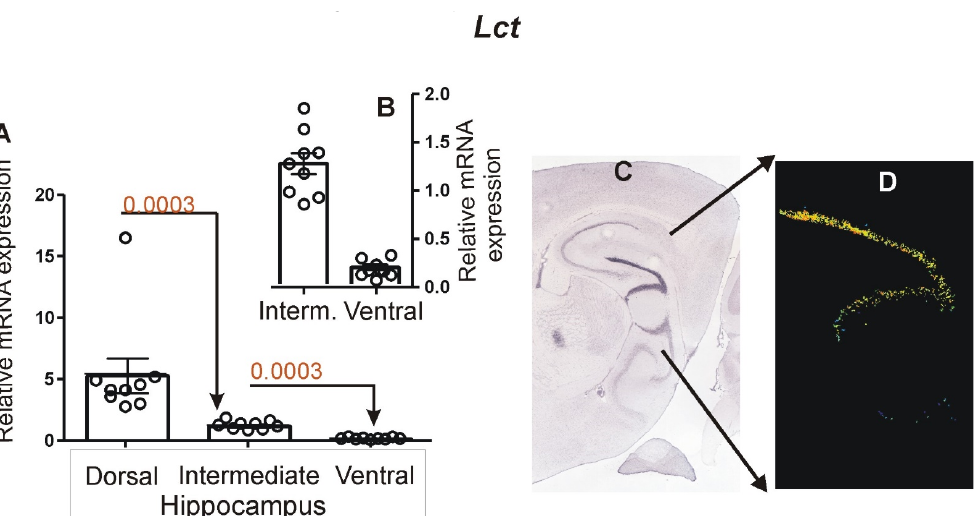
Figure 6. Hippocampal expression of Lct . ( A ) Results of PCR analysis performed on dissected samples of dorsal, intermediate and ventral hippocampus. ( B ) Details of Lct expression in intermediate and ventral parts presented with altered scale at the Y axis. ( C ) Pattern of expression in brain slice (ISH image) containing all hippocampal subdivisions derived from Allen Mouse Brain Atlas (https://mouse.brain ‐ map.org/, accessed on 24 June 2021) [13]. ( D ) Expression detection mask retrieved from Allen Mouse Brain Atlas showing dorsal hippocampus with highest Lct expression. Data are presented as mean ± SEM (column bar graphs) overlaid on scatter plots. The Trhr gene displayed an opposite pattern of expression characterized by the high ‐ est level of expression in the ventral hippocampus ( n = 9) and lowest in the dorsal hippo ‐ campus ( n = 7) as indicated by the real ‐ time PCR analysis (Figure 7). In the case of the two samples from the dorsal hippocampus, we have obtained negative results for all repeats of the PCR analysis (triplicate). Because of an uncertainty about the reasons for the nega ‐ tive results (technical error vs. lack of expression), we omitted these two samples from the statistical analysis, reducing the total number of samples to seven. The intermediate part ( n = 9) displayed an intermediate level of expression of Trhr . The differences were signifi ‐ cant, with p = 0.0009 (dorsal vs. intermediate part) and p = 0.0003 (intermediate vs. ventral part).